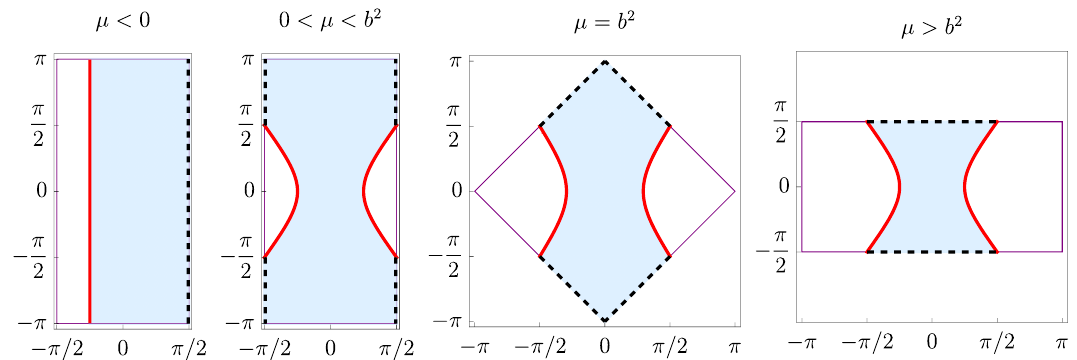
Figure 1: These conformal diagrams are explained in Figure 3. They show a progres- sion from AdS (left two plots) via Minkowski 2